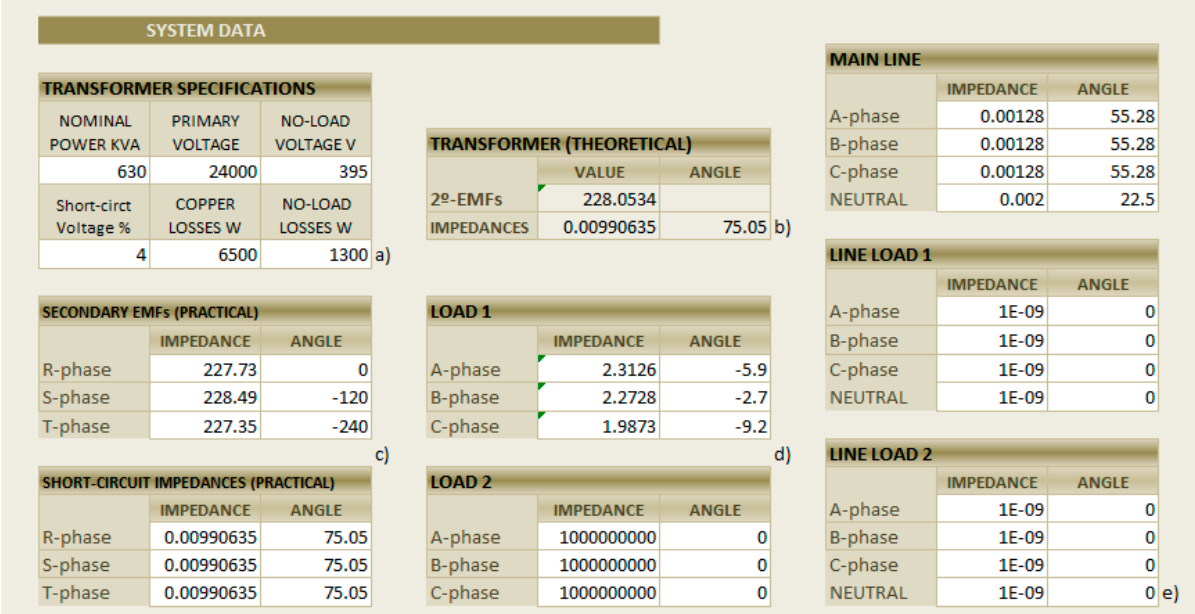
Figure 9. Simulation scheme of the distribution network using Multisim software.